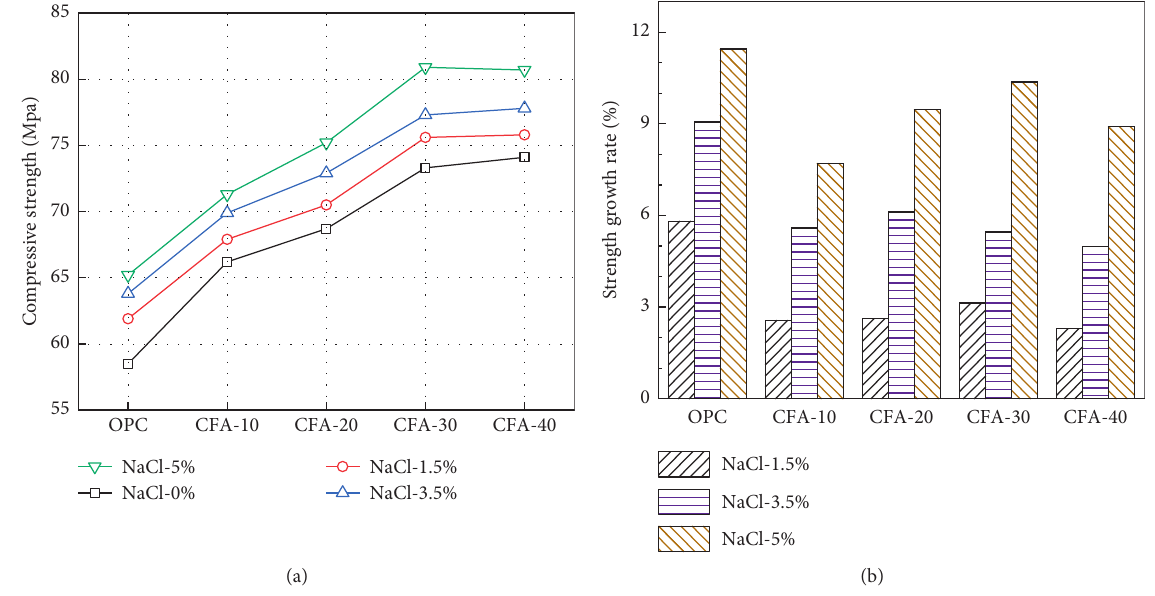
Figure 3: Compressive strength and growth rate of CFA. (a) Compressive strength. (b) Strength growth